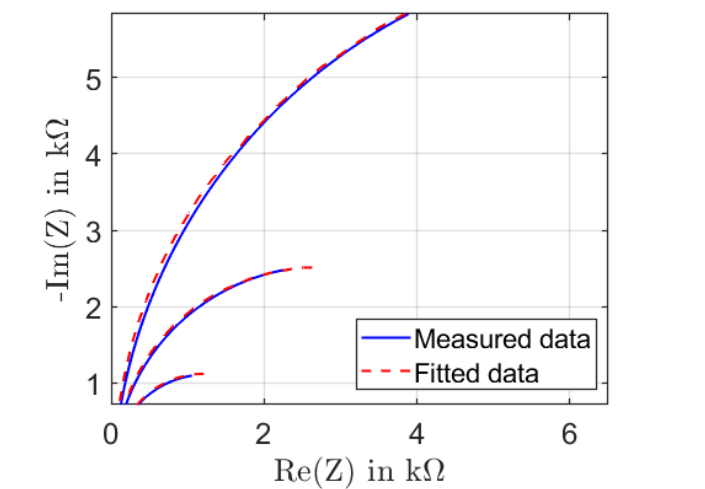
Figure 7. Fitting of the impedance